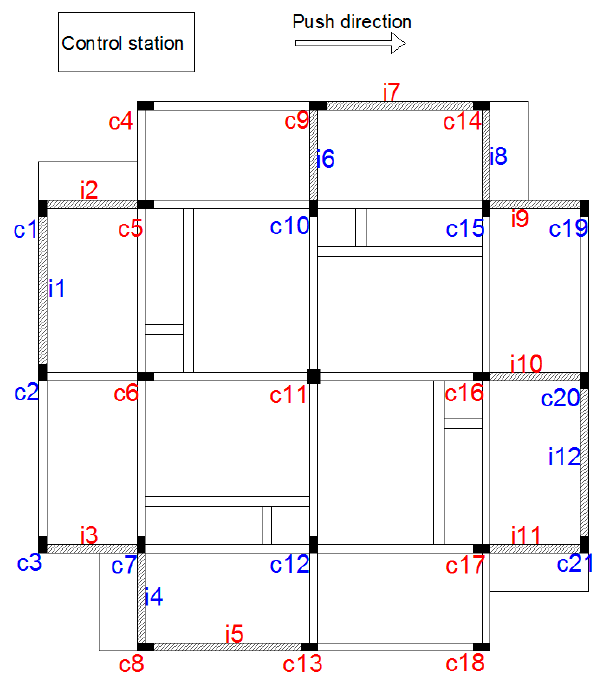
Figure 11. Column (“c”) and infill (“i”) labels.